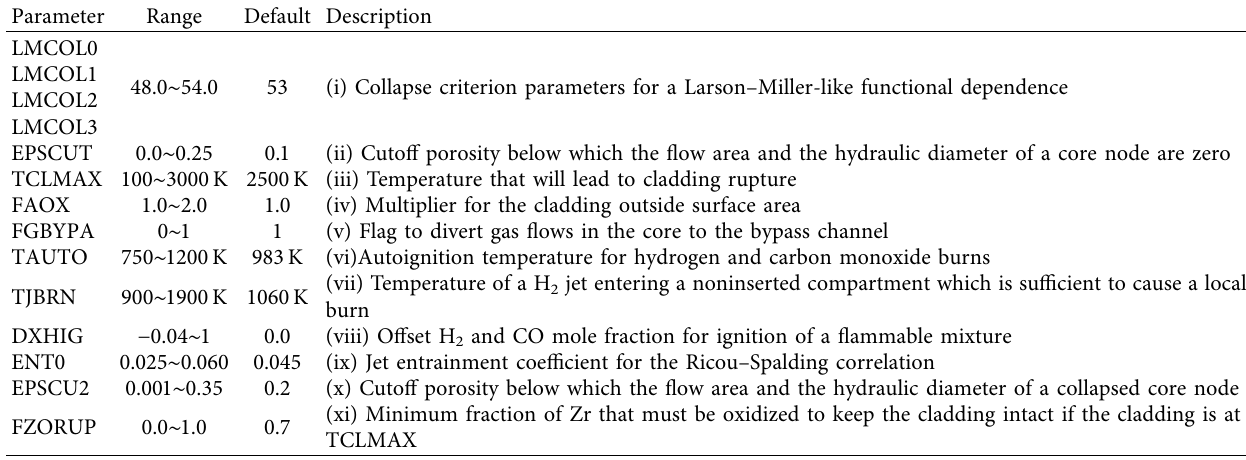
Table 5: List of MAAP parameters reviewed in the sensitivity study.